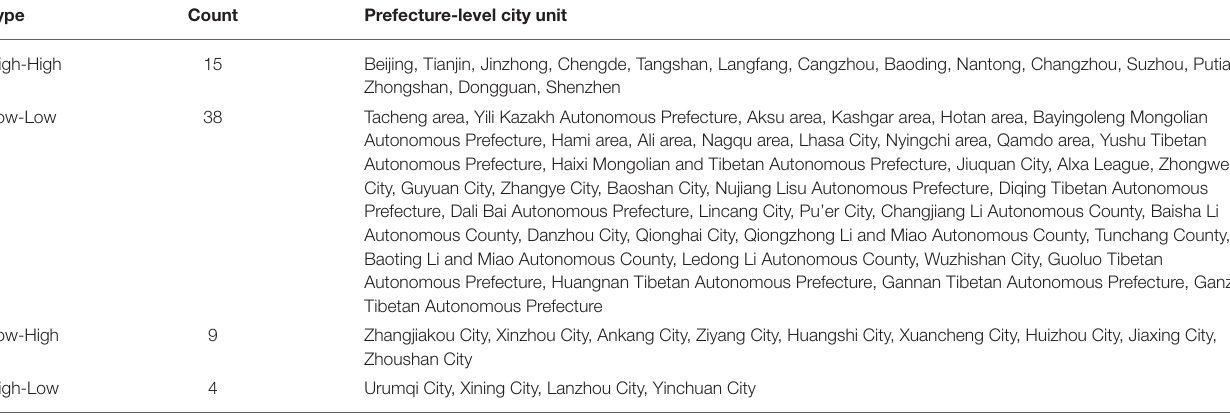
TABLE 2 | Cluster statistics of elite hospitals.